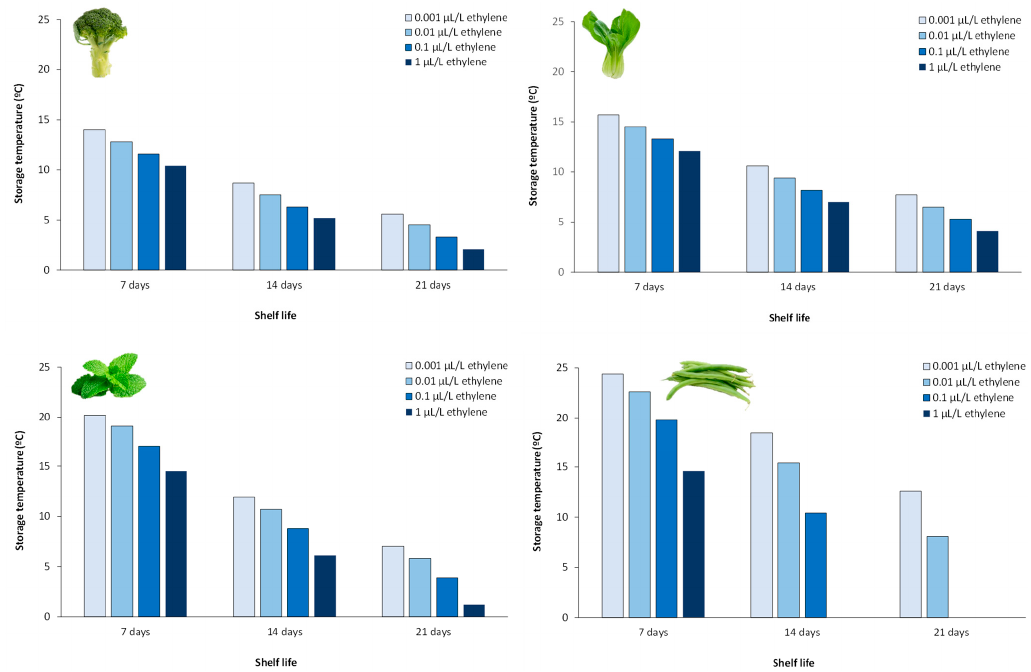
Figure 6. Effect of reduction of ethylene concentrations to increment the storage temperature in refrigeration facilities to maintain the shelf life of broccoli, pak choi, mint, and green beans (elaborated from data published by Lie et al. [11]).